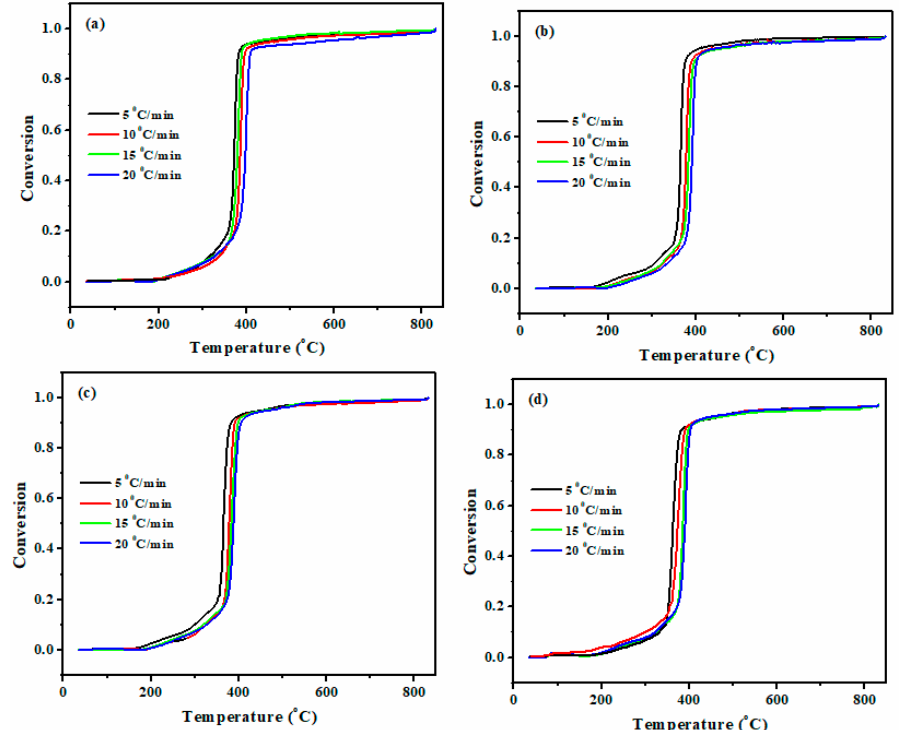
Figure 3. Degradation conversion profiles of nanocomposites at various heating rates for ( a ) blank PU, ( b ) PU / Nanoclay-1, ( c ) PU / Nanoclay-3, and ( d ) PU / Nanoclay-5.